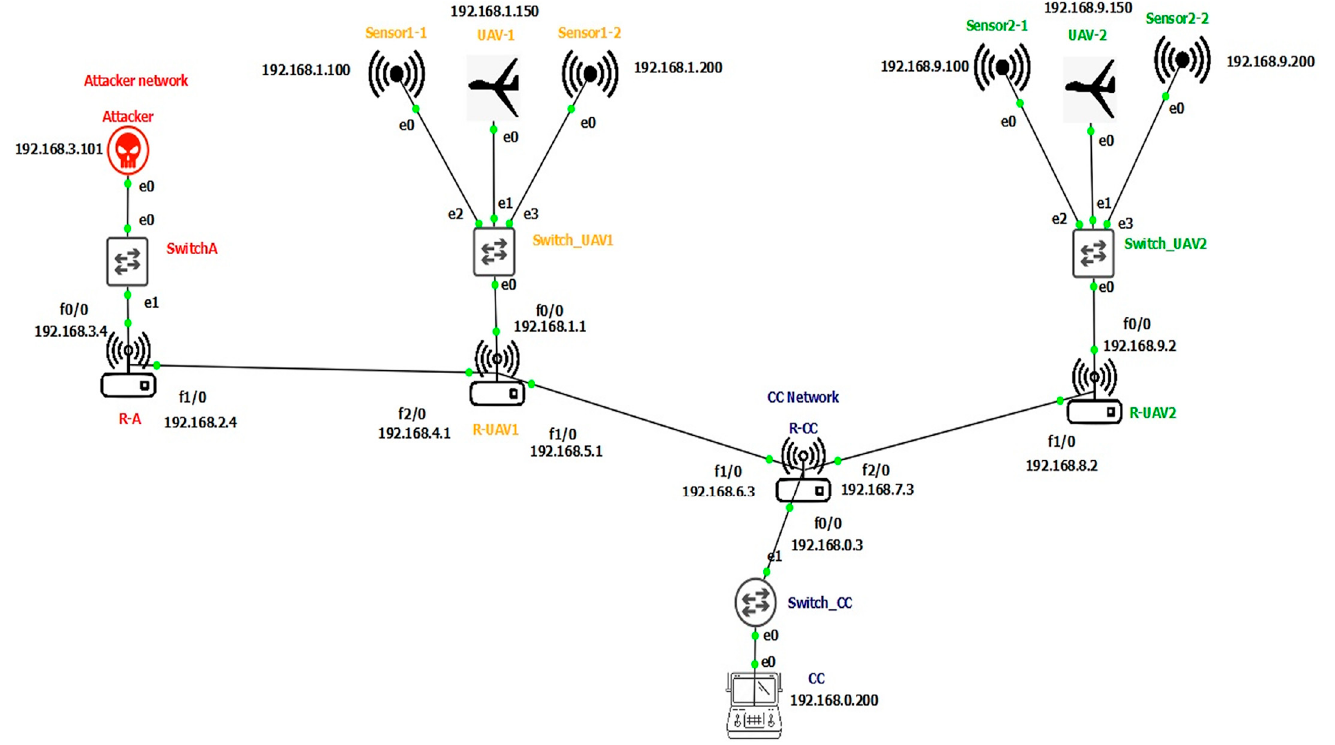
Figure 8. Topology of the test network at the stand.